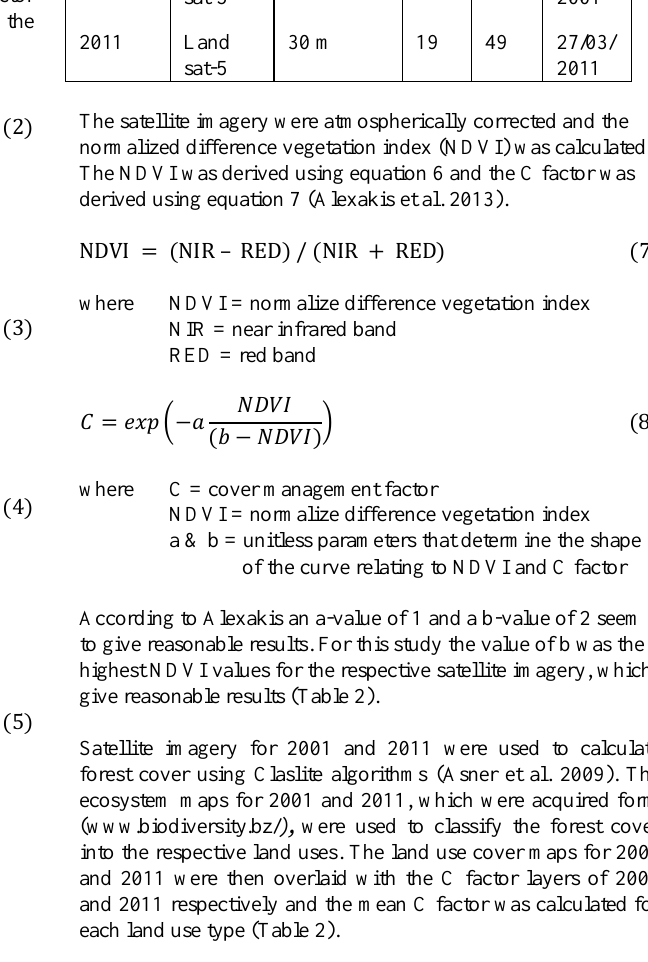
Table 2. Land Use and mean C factor for 2001 and